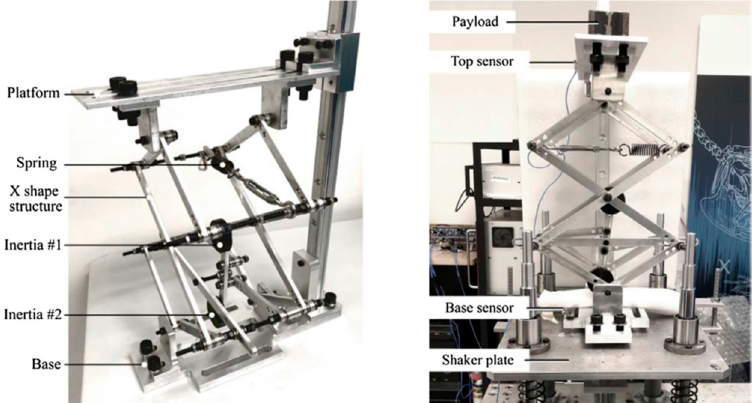
Figure 5. New human body-inspired anti-vibration structure with nonlinear inertial coupling (HBIAVS-NI) prototype structure [60].